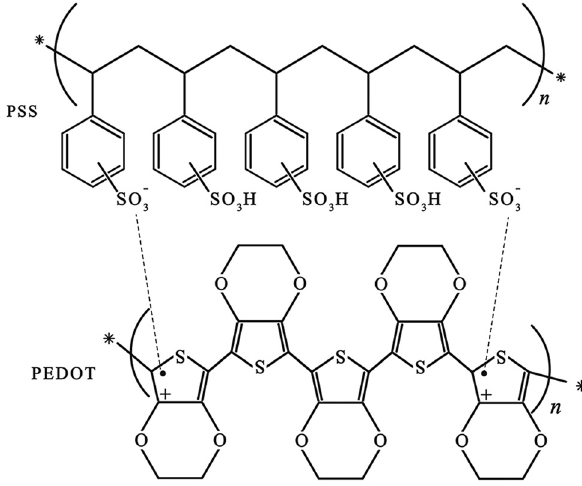
Figure 2: The chemical structure of